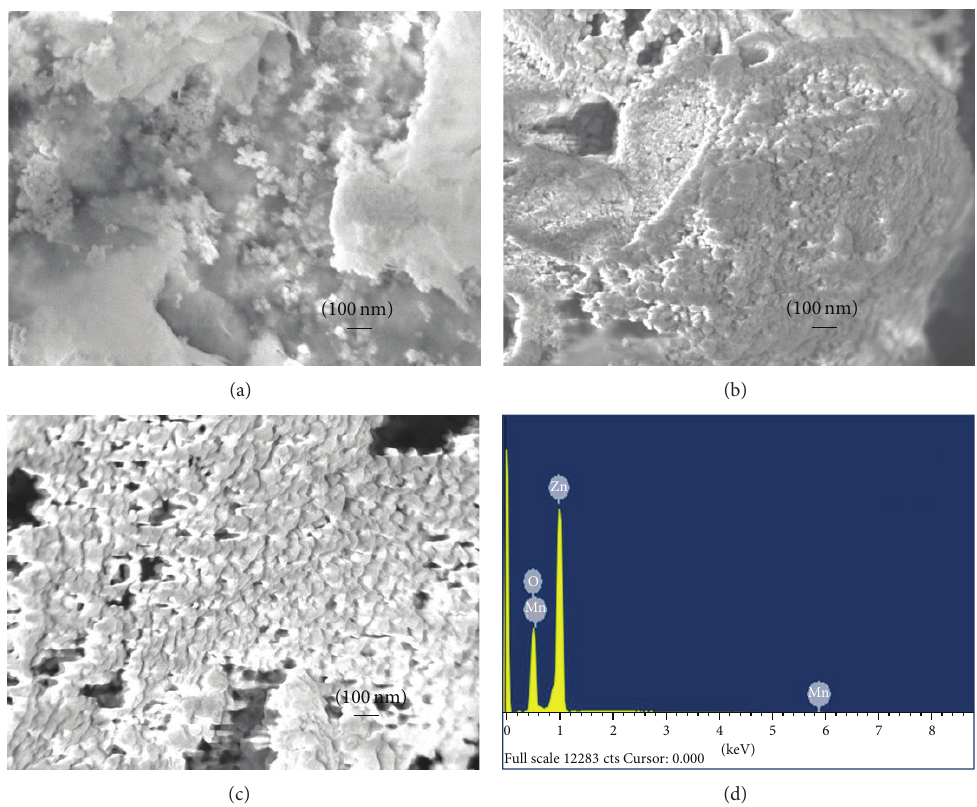
Figure 3: SEM micrographs of (a) as-burnt and annealed samples at (b) 400 ∘ C and (c) 600 ∘ C (d) EDX pattern of as-burnt Zn 0.95 Mn 0.05 O.